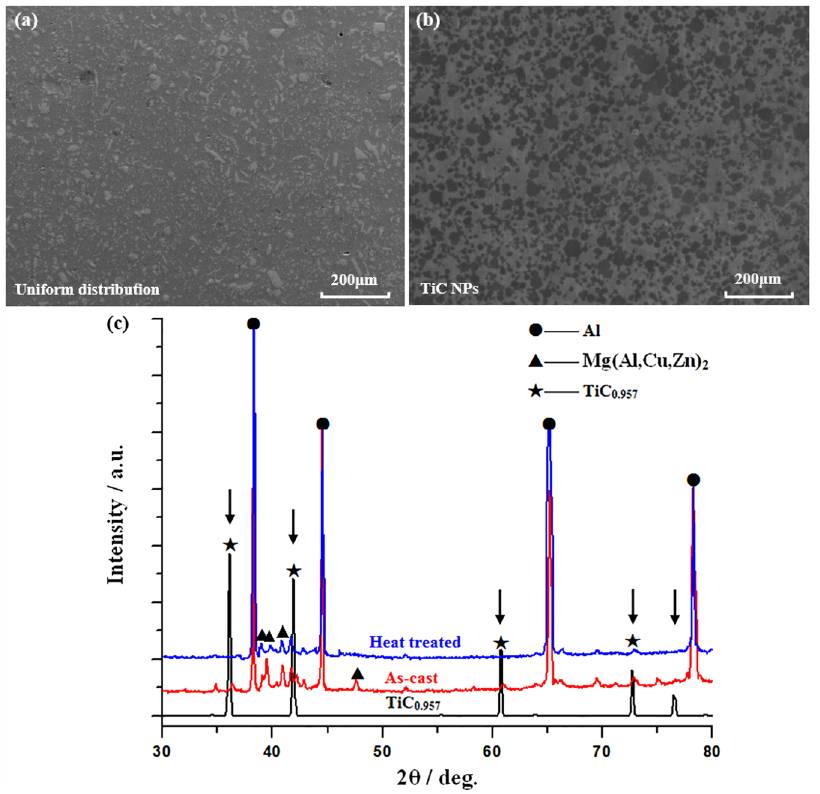
Figure 6. ( a , b ) FESEM characterizations of Al–TiC master alloy prepared by a molten salt-assisted processing method. ( c ) XRD patterns of AA7075 alloys before and after nano-treating with TiC